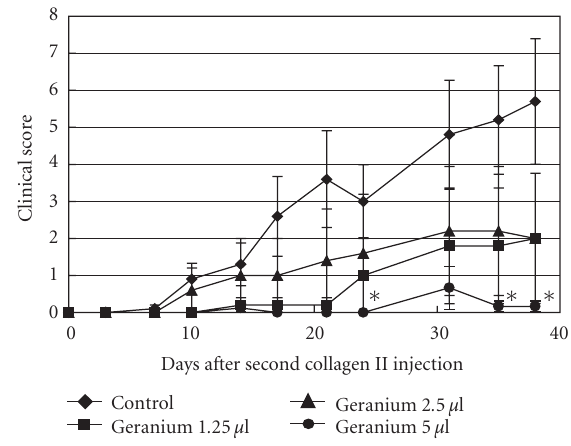
Figure 6: E ff ects of intraperitoneal administration of geranium oil on the inflammatory score. Collagen II with CFA was subcuta- neously injected to the base of the tail of the mice on days − 21 and 0. Geranium oils were given from day 0 to 21, 5days/week. The arthri- tis was scored as described in material and methods. Each value rep- resents an average from 5–10 mice and the standard error. ∗ P < . 05 di ff erence from